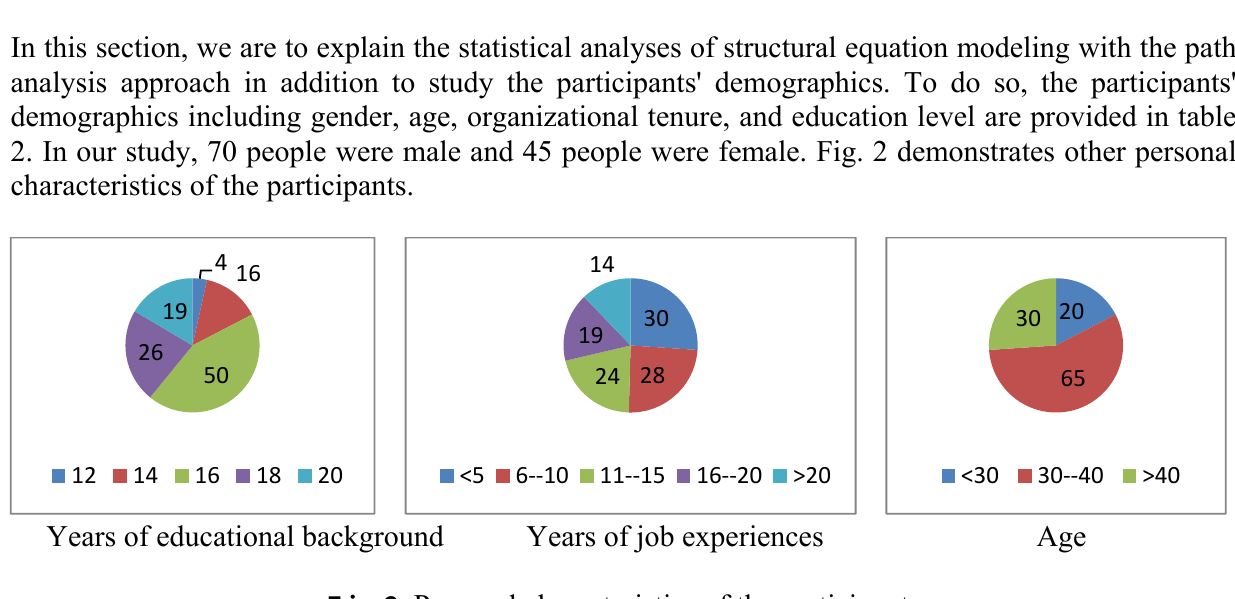
Fig. 2. Personal characteristics of the participants